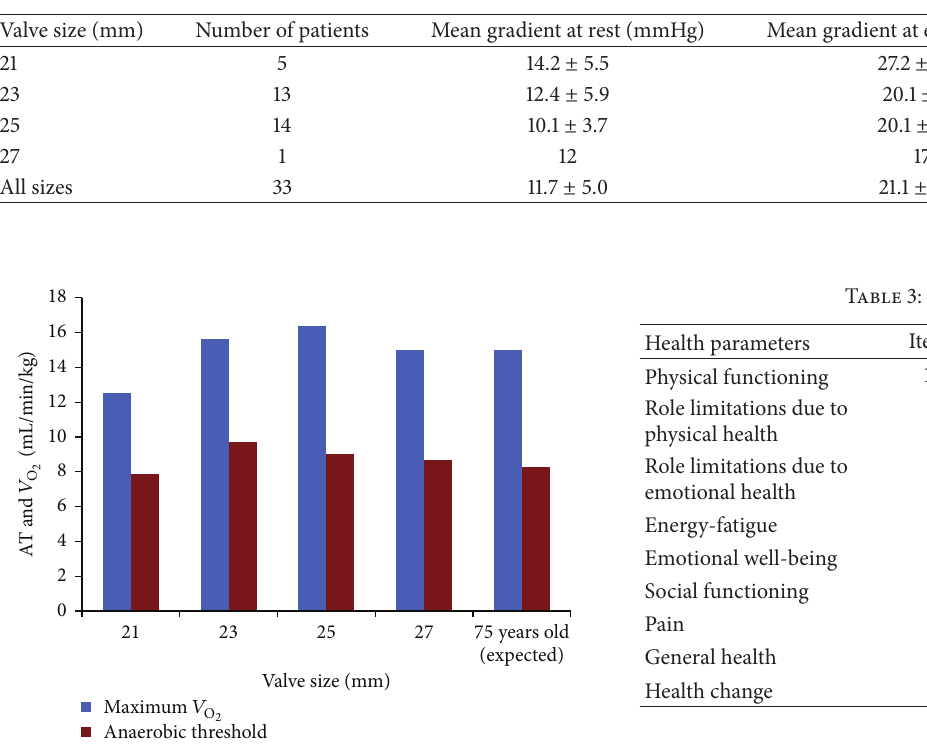
and anaerobic threshold. O 2